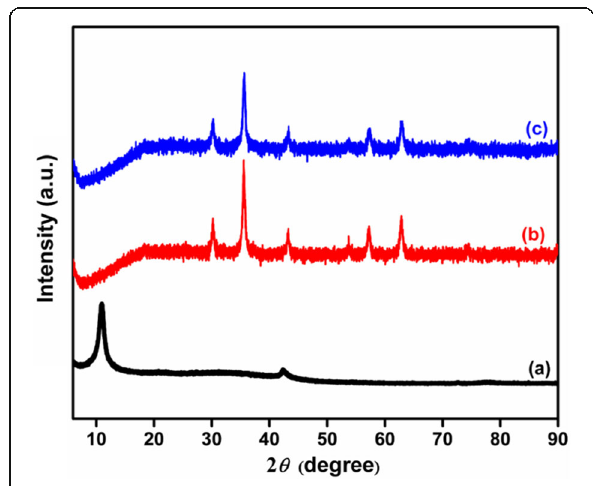
Fig. 4 XRD patterns of ( a ) GO, ( b ) MGO, and ( c ) MGO-CD